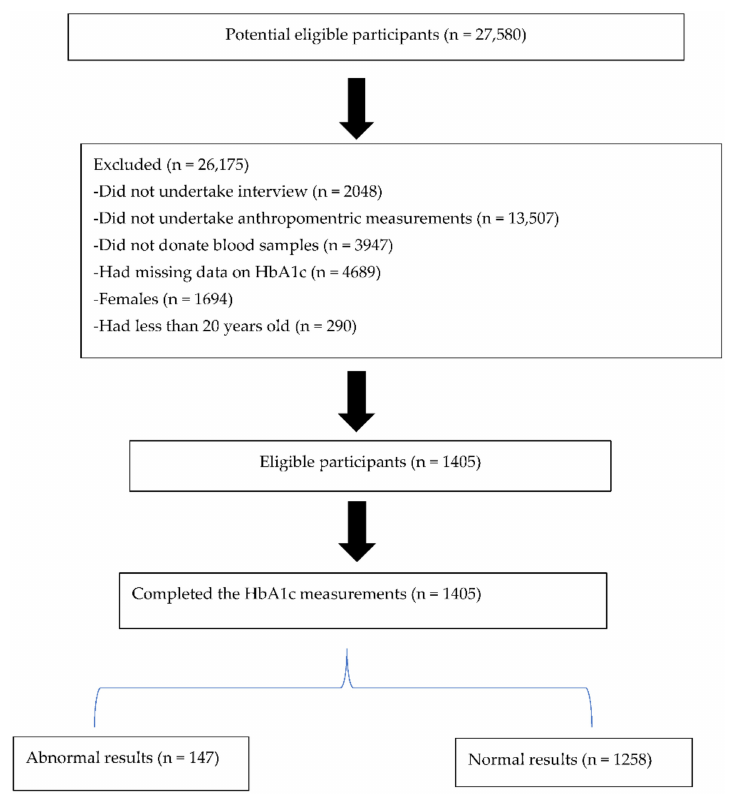
Figure 1. Flow diagram of subject selection for this